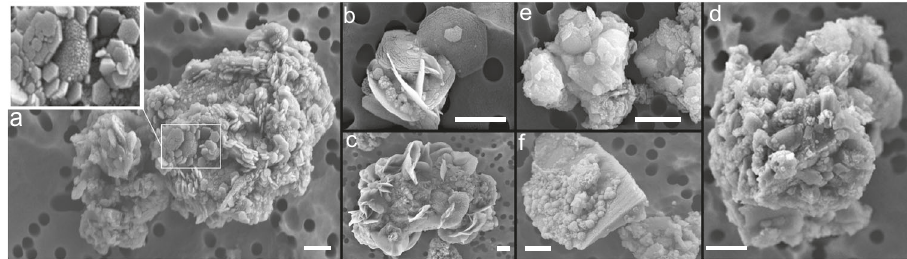
Fig. 2 The morphology of mineral grains in deep TALDICE investigated through SEM. Samples were retrieved from TALDICE sections at the depth of 1560 m ( a , d , e , f ) and 1534 m ( b , c ). Scale bar: 1 µ m.